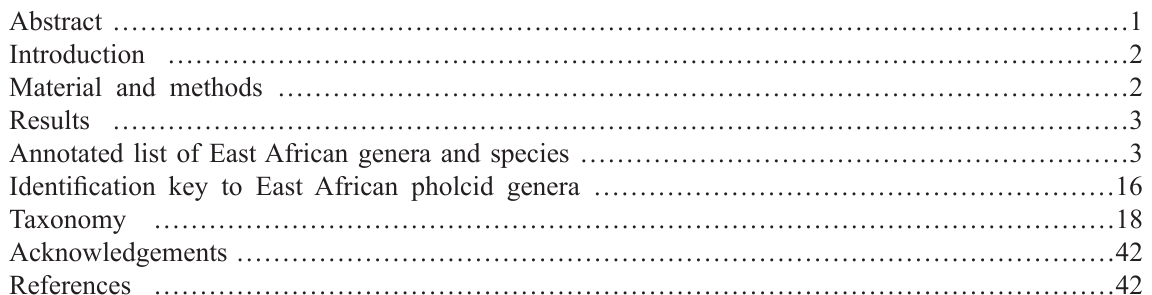
Abstract. This paper summarizes current knowledge about East African pholcids. East Africa is defined as the area from 12°S to 5°N and from 28° to 42°e, including all of uganda, Kenya, Burundi, rwanda, and Tanzania. An annotated list of the 15 genera and 87 species recorded from this area is given, together with distribution maps and an identification key to genera. Most East African species (90%) belong to one of only six genera: Buitinga Huber, 2003 (21 species); Smeringopus Simon, 1890 (18); Pholcus Walckenaer, 1805 (17); Spermophora Hentz, 1841 (12); Leptopholcus Simon, 1893 (5) and Quamtana Huber, 2003 (4). Eight species for which DNA sequence data have been published recently are newly